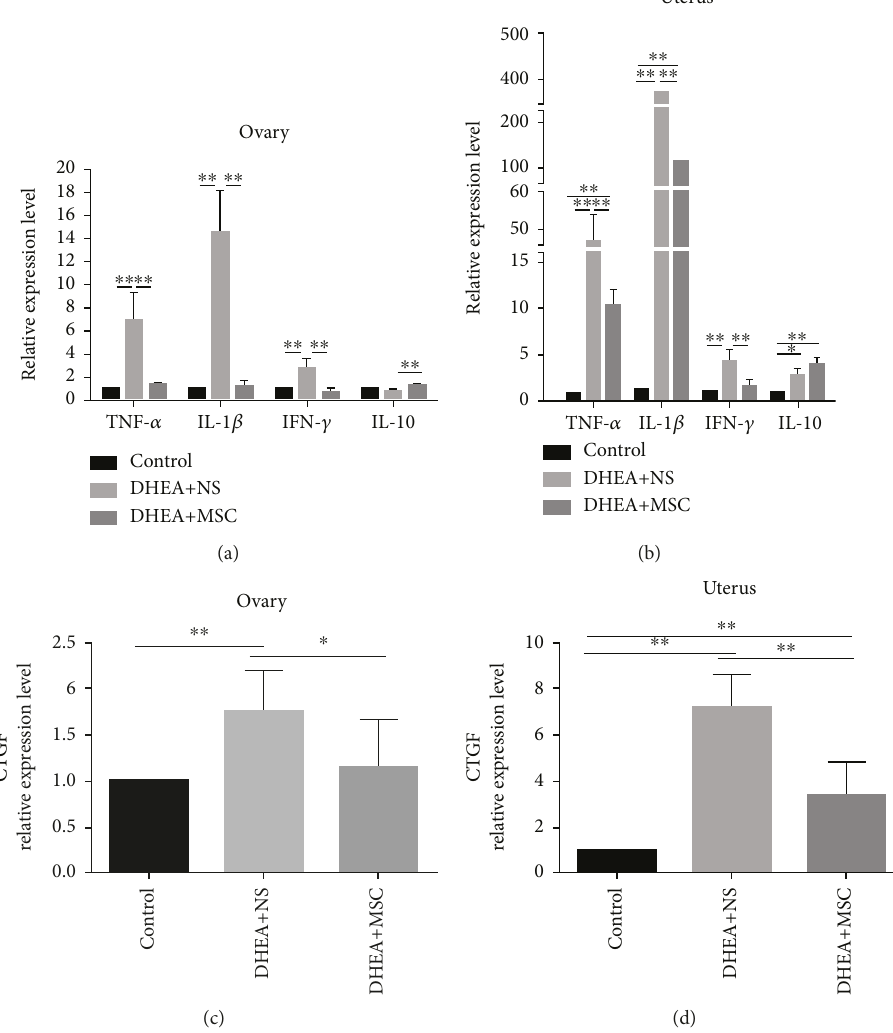
Figure 3: hUC-MSC treatment alleviates ovarian and uterine local in fl ammatory response and tissue fi brosis in PCOS mice. (a, b) Quantitative RT-PCR analysis of the expression of proin fl ammatory factors (TFN- α , IL-1 β , and IFN- γ ) and anti-in fl ammatory factor (IL-10) in the ovaries and uterus. (c, d) Quantitative RT-PCR analysis of the expression of connective tissue growth factor (CTGF) in the ovaries and uterus. Values are expressed as the means ± SEM . n = 8 per group. ∗ P < 0 05 and ∗∗ P < 0 01